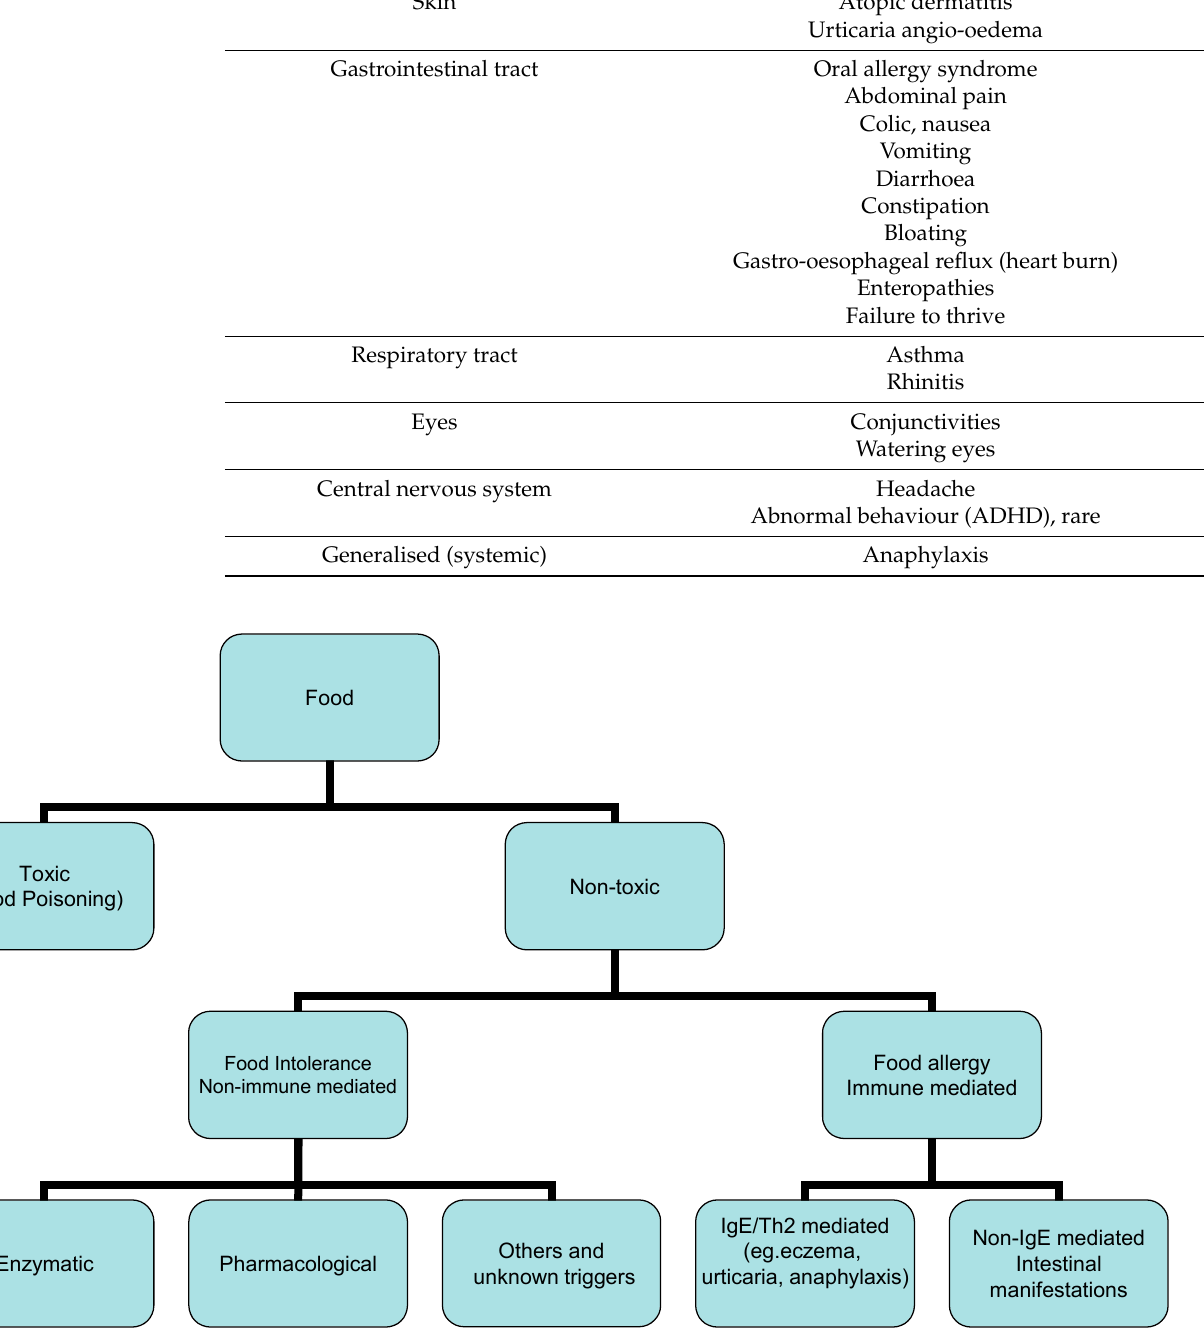
Figure 2. Adverse reactions to food.